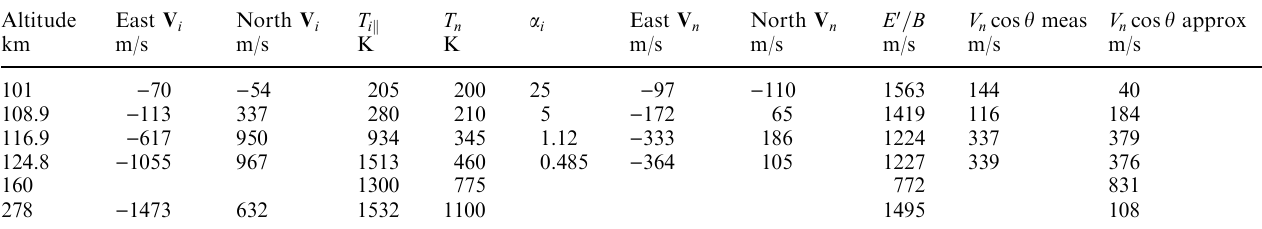
Table 2 . Measured and inferred ionospheric parameters between 34.17 and 34.34 UT, for an 80 mV/m field Altitude